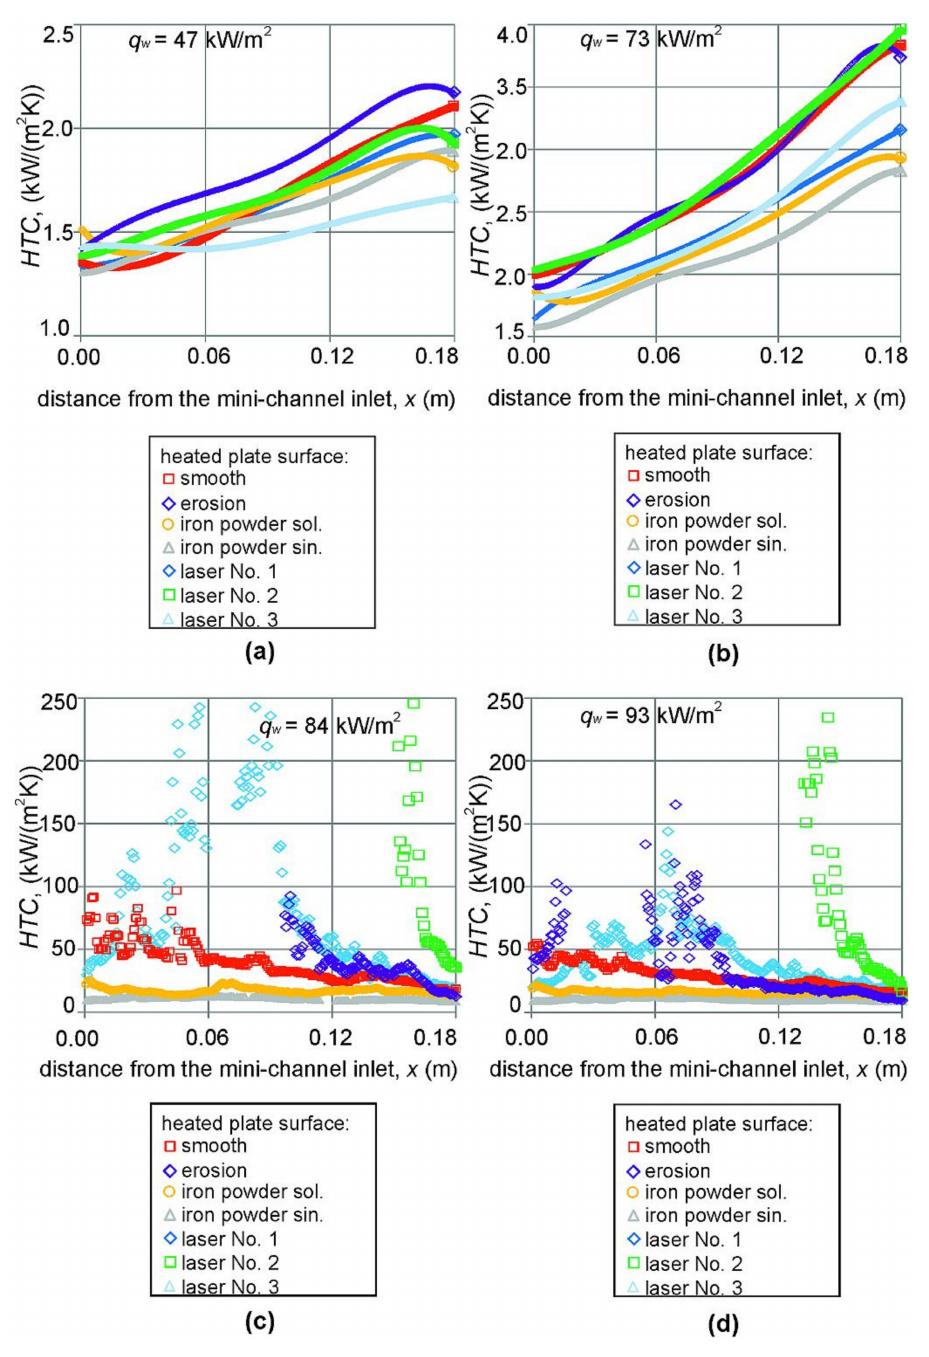
Figure 11. Heat transfer coefficient vs. distance from the mini-channel inlet: subcooled boiling region ( a , b ) and saturated boiling region ( c , d ); smooth and several modified heated plate surfaces; vertical channel orientation (90 ◦ ); average mass flux of 353 kg/(m 2 · s); FC-72; L IRT = 180